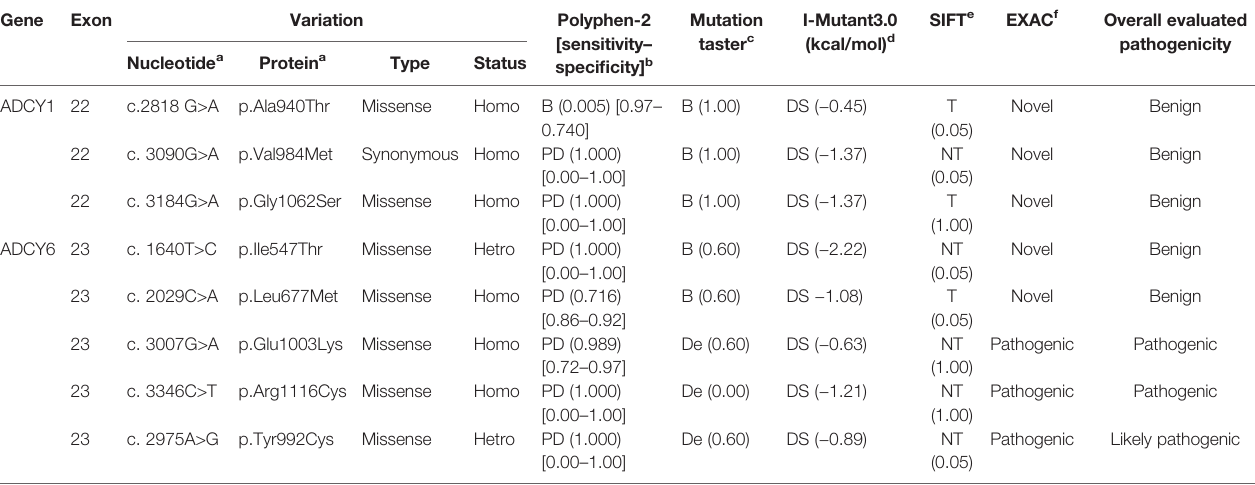
TABLE 2 | Predicted protein structure and disease-causing effects of mutations in AC